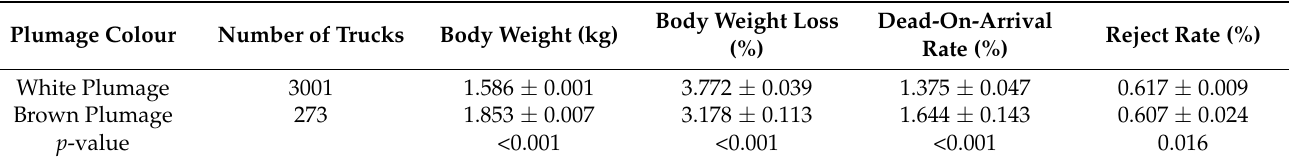
Table 3. Average body weight, body weight loss, dead-on-arrival rate, and reject rate according to plumage colour (mean ± SEM).